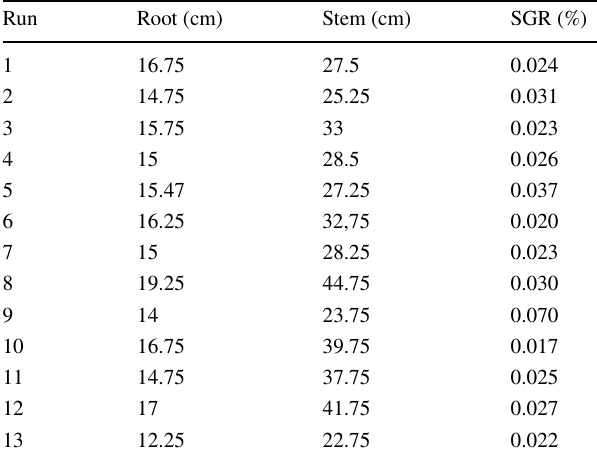
Table 2 Vetiver root and stem length at the experiment Table 3 Response value at optimum